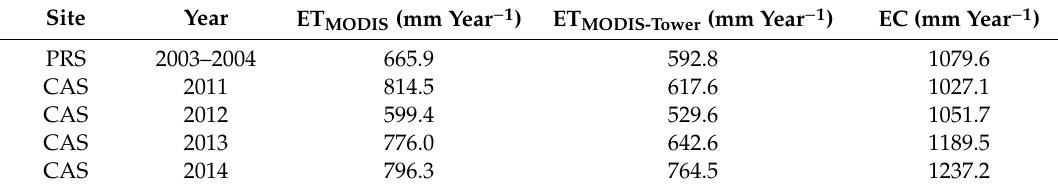
Table 4. Annual MOD16 ET, tower-driven MOD16 ET estimates, and EC measurements at the PRS and CAS